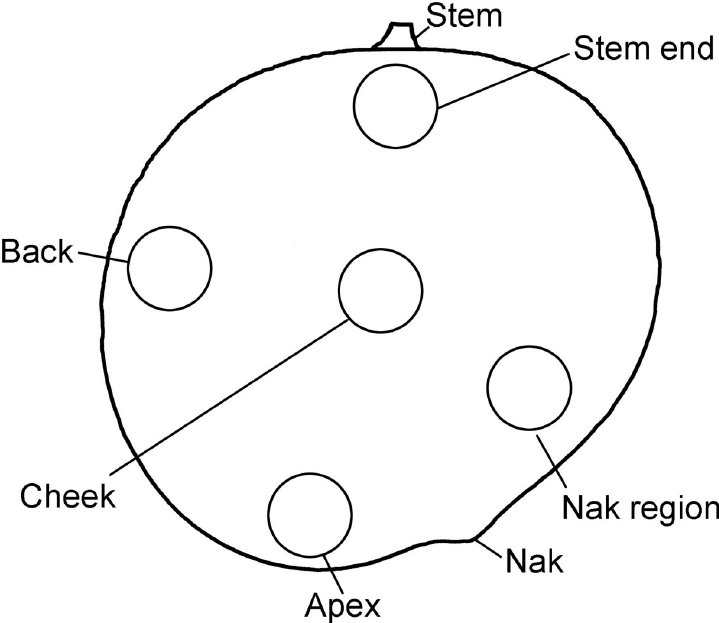
Fig 1. Sketch of mango fruit showing the different regions of the fruit surface sampled. These regions include stem end, cheek, apex, back and nak.